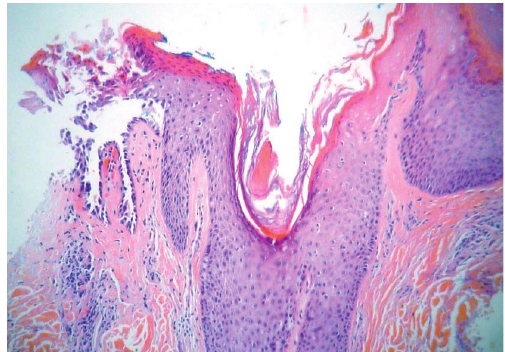
Figure 2: Incidental focal acantholytic dyskeratosis occurring in a biopsy of lichen simplex chronicus. (200X magnification, hema- toxylin, and eosin